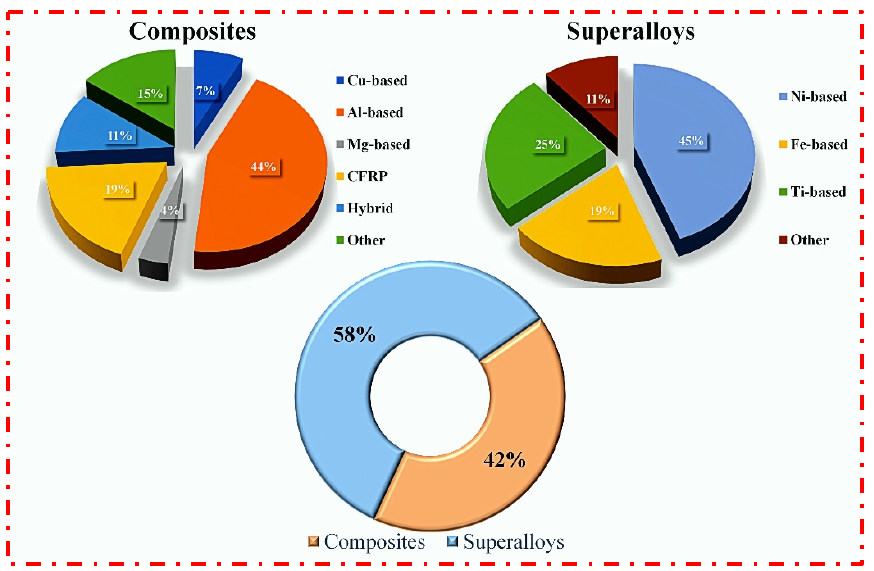
Figure 18. The percentage range of energy measurements between superalloys and composite machining according to their main material type.